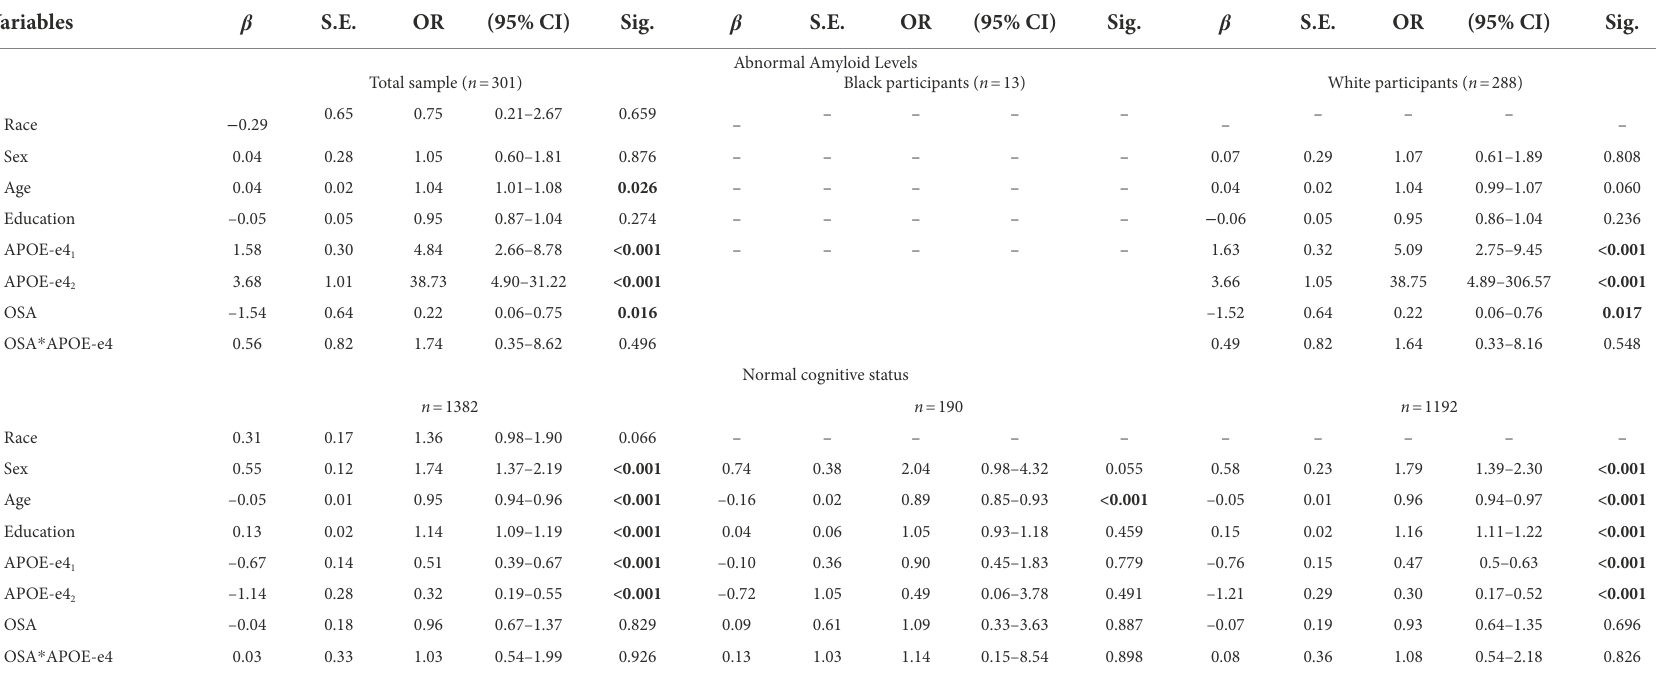
TABLE 3 Logistic regression analyses of the influence of APOE-e4, OSA, and their interaction on amyloid beta and cognitive status.